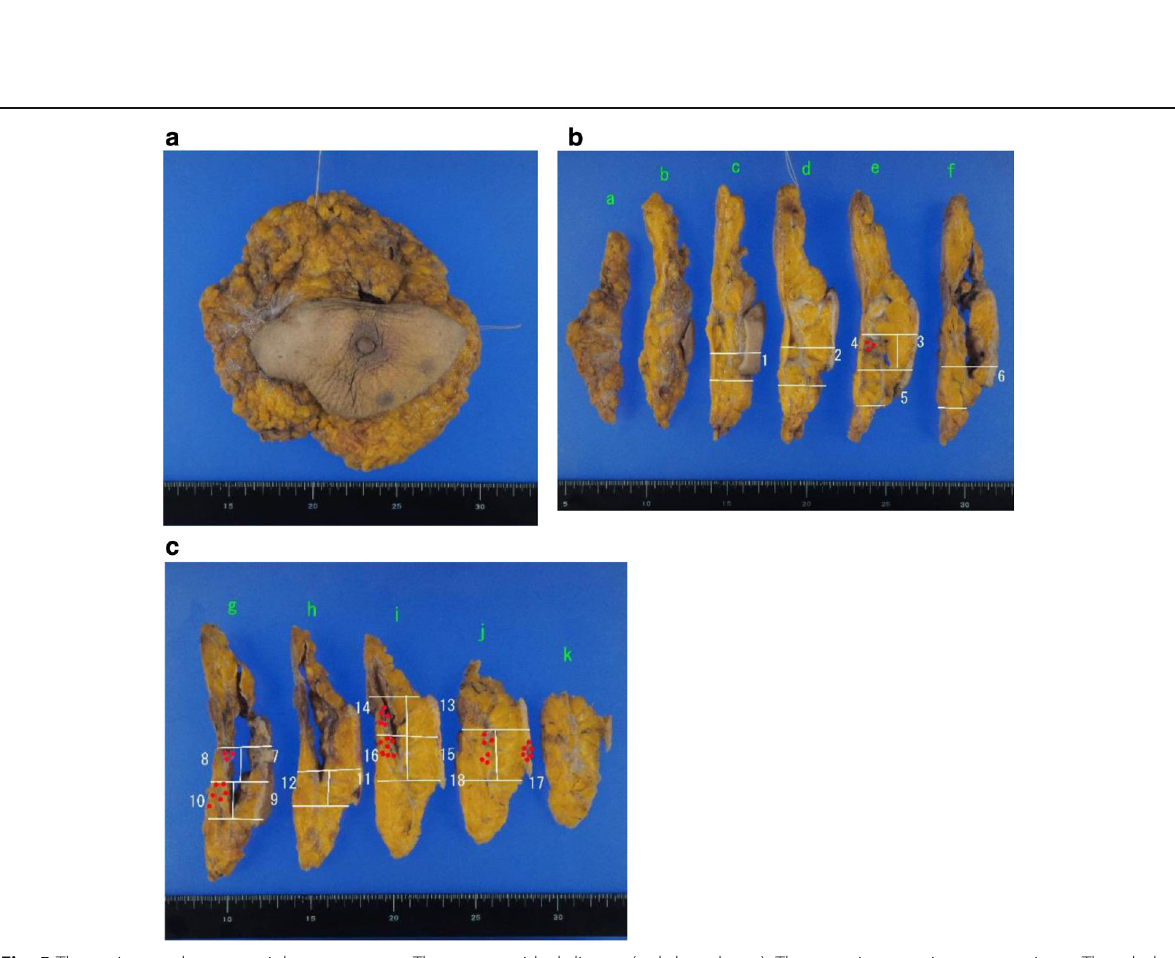
Fig. 5 The patient underwent a right mastectomy. There was residual disease (red dotted area). The resection margin was negative. a The whole sample. b , c The cross-section of the sample